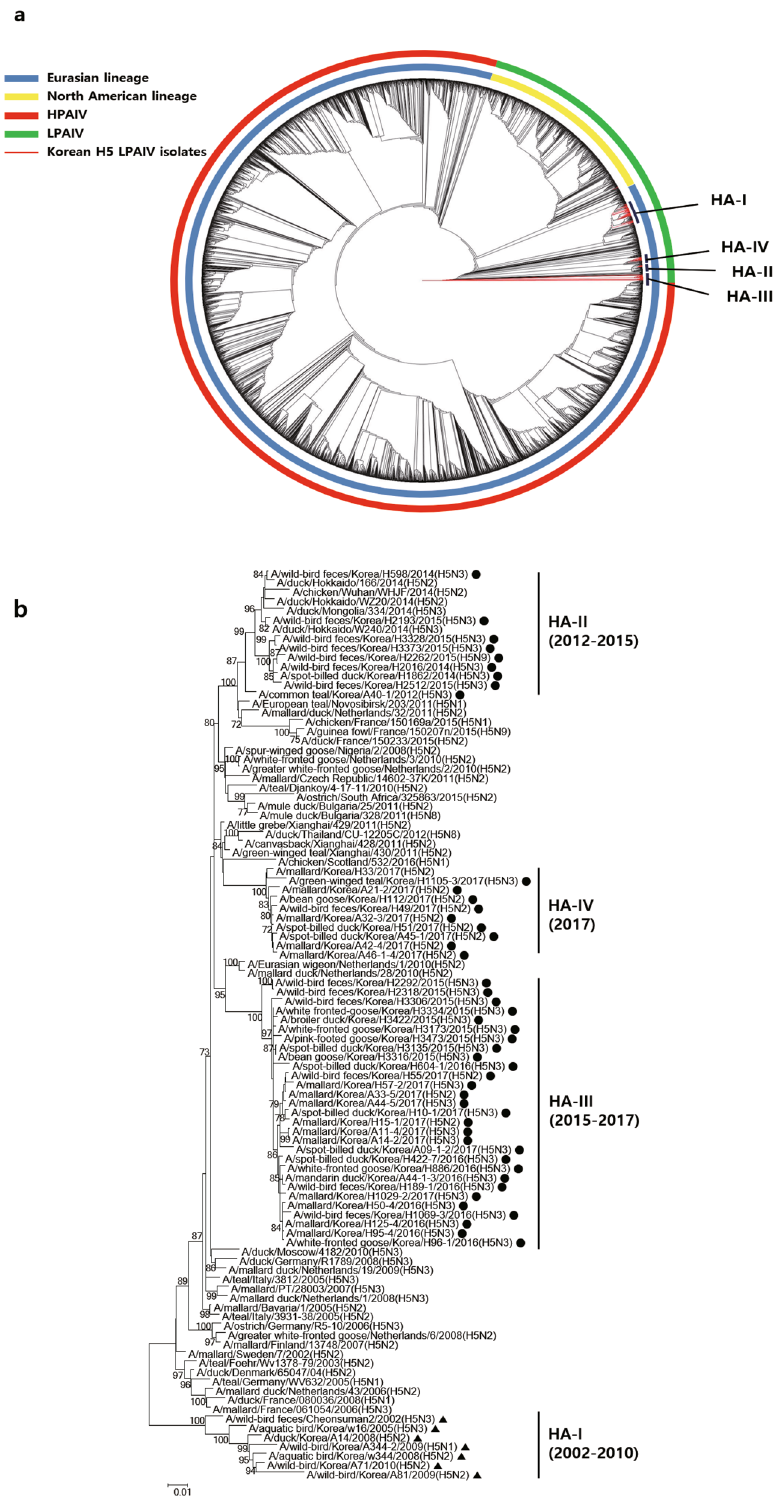
Figure 1. Phylogenetic analysis of the HA gene of H5 LPAIVs. ( A ) Maximum-likelihood phylogenetic tree of the HA genes of 48 H5 LPAIVs isolated in South Korea between 2010 and 2017 (red lines), along with all completed sequences ( n = 5,283) of H5 genes of avian influenza viruses that were available in the using the NCBI Influenza Virus Database and GISAID. Evolutionary analyses were conducted in RAxML. ( B ) Maximum-likelihood phylogenetic tree of a subset of H5 genes belonging to the Eurasian lineage. The phylogenetic tree was generated in MEGA6. Bootstrap values (1,000 replicates) > 70% are displayed on the branch nodes. H5 LPAIVs isolated in South Korea from 2012 to 2017 are indicated by dots, and those isolated at other times are indicated by triangles. Sequences were acquired from GISAID and the NCBI Influenza Virus Database. HPAIV, highly pathogenic avian influenza virus; LPAIV, low pathogenic avian influenza